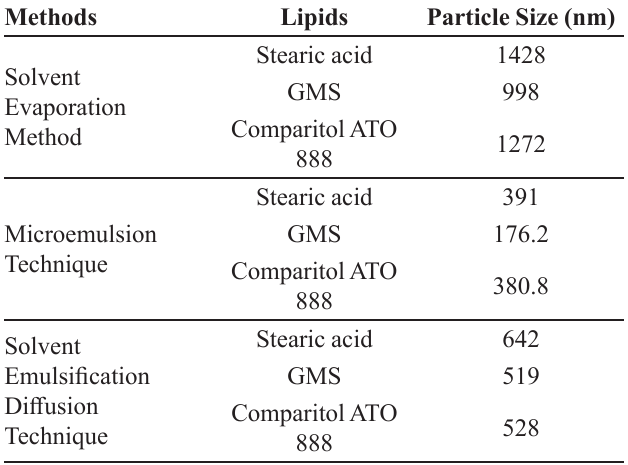
TABLE III - Optimization of drug lipid ratio